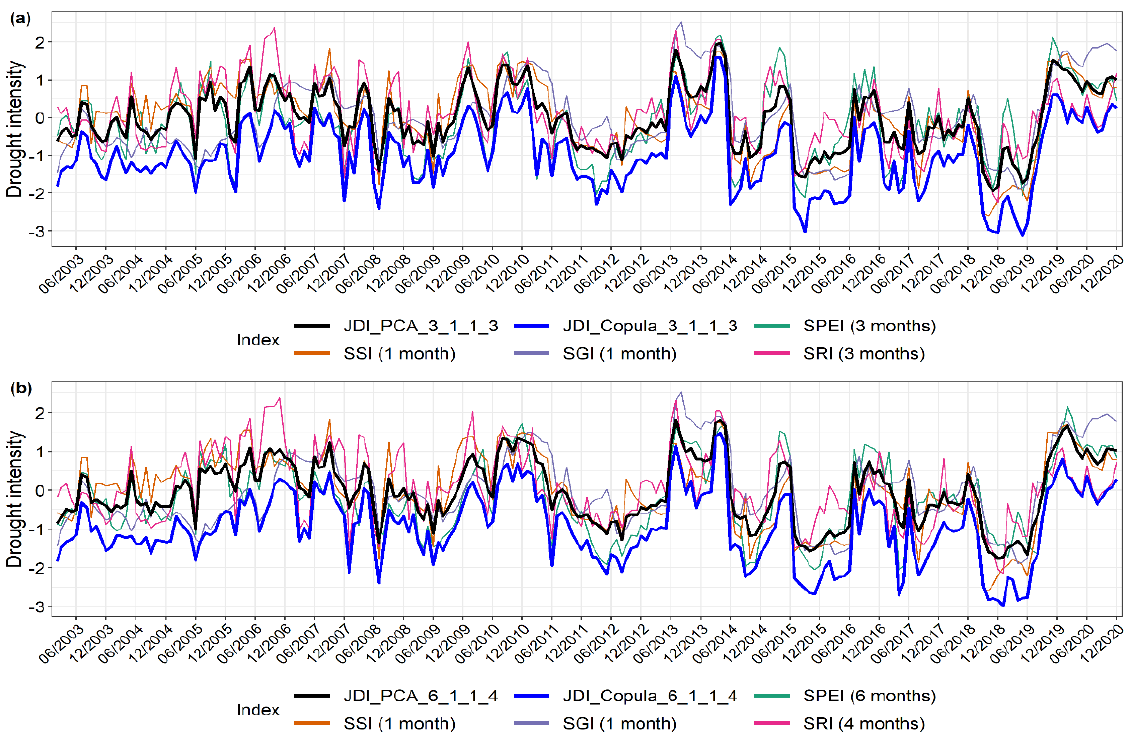
Figure 4. Time series of JDI_PCA and JDI_Copula during 2003 to 2020 for scales ( a ) 3_1_1_3 and ( b ) 6_1_1_4, where the scales are in the order of SPEI, SSI, SGI, and SRI, along with time series of the integrated indices SPEI, SSI, SGI, and SRI with their respective scales.